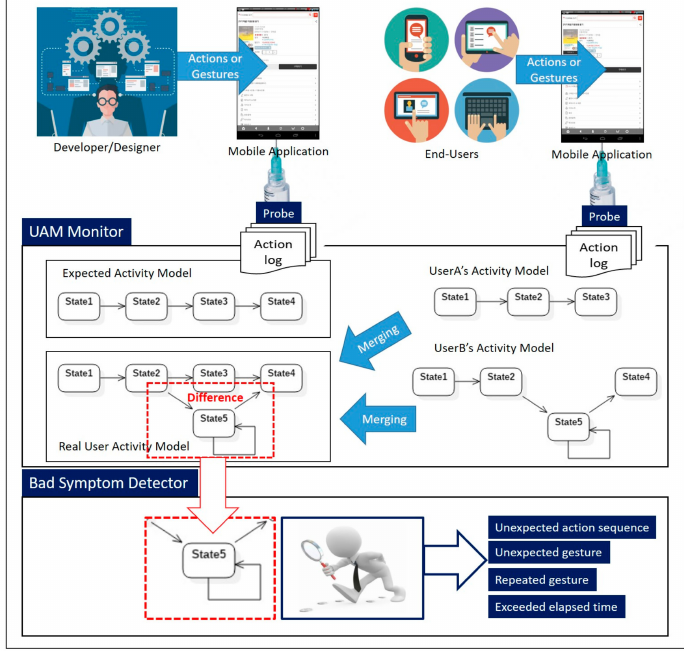
Figure 3. Overview of automatic user activity analysis